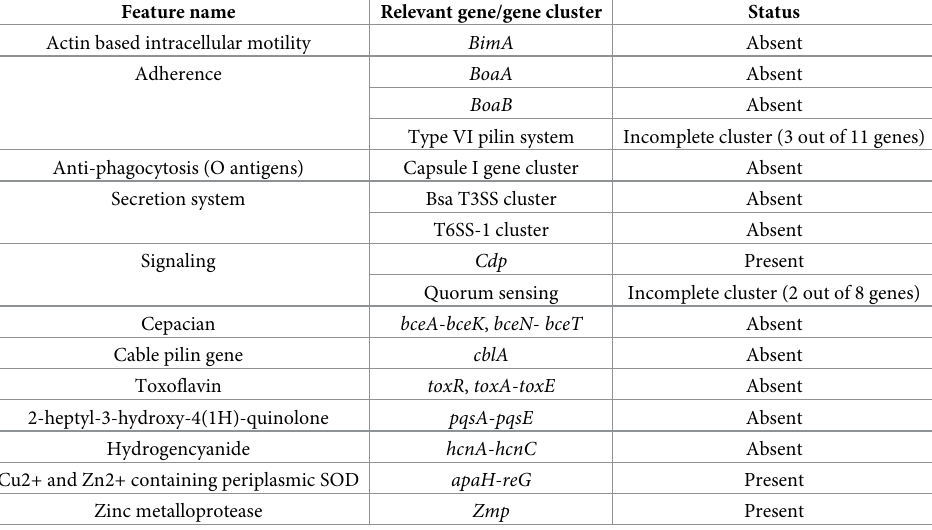
Table 2. List of major virulence related genes present or absent in B . contaminans